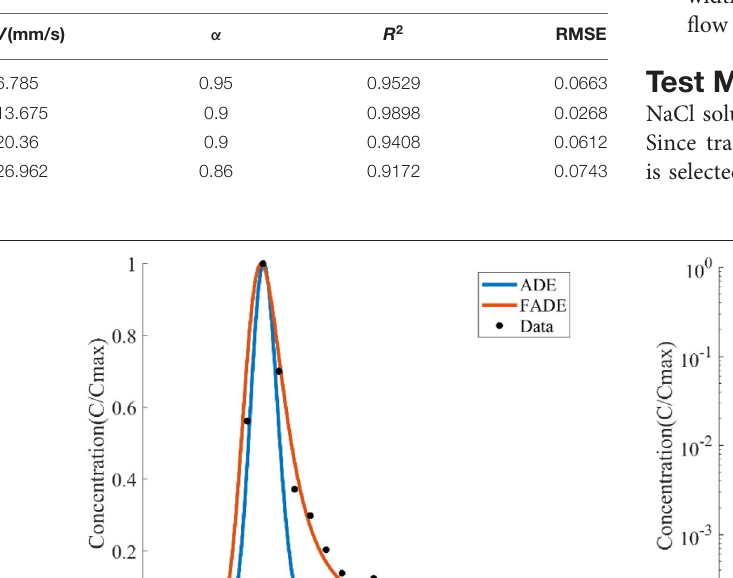
TABLE 1 | Parameter fitting of the FADE model with fracture width of 4mm at different flow rates.